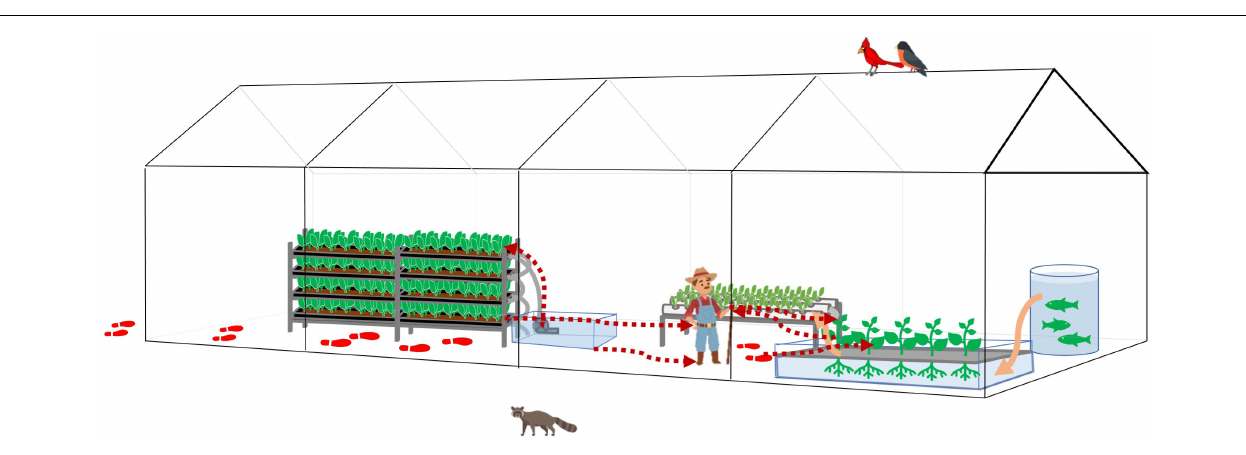
FIGURE 7 | The bacteria transmission affected by human farming activities in a typical greenhouse hydroponic/aquaponic ecosystems. Bacteria transmissions follow the red dotted arrow lines. The footprints indicate the potential contaminants brought in by human activities and transmitted inside the greenhouse. The water flow follows orange solid arrow lines or the water pipes connecting each water